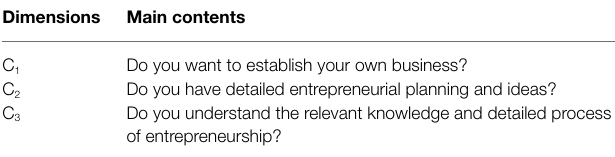
TABLE 3 | Entrepreneurial intention measurement.